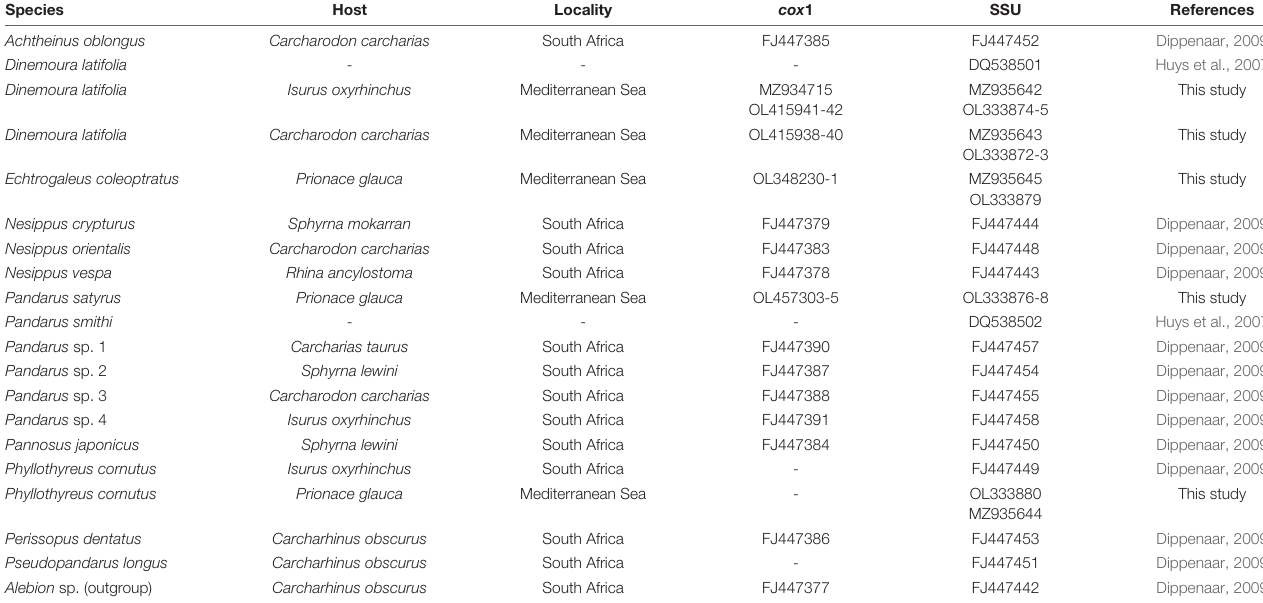
TABLE 2 | Species, host, locality, and accession numbers of cox 1 and SSU sequences of pandarid copepods included in the phylogenetic analysis shown in Figure 2